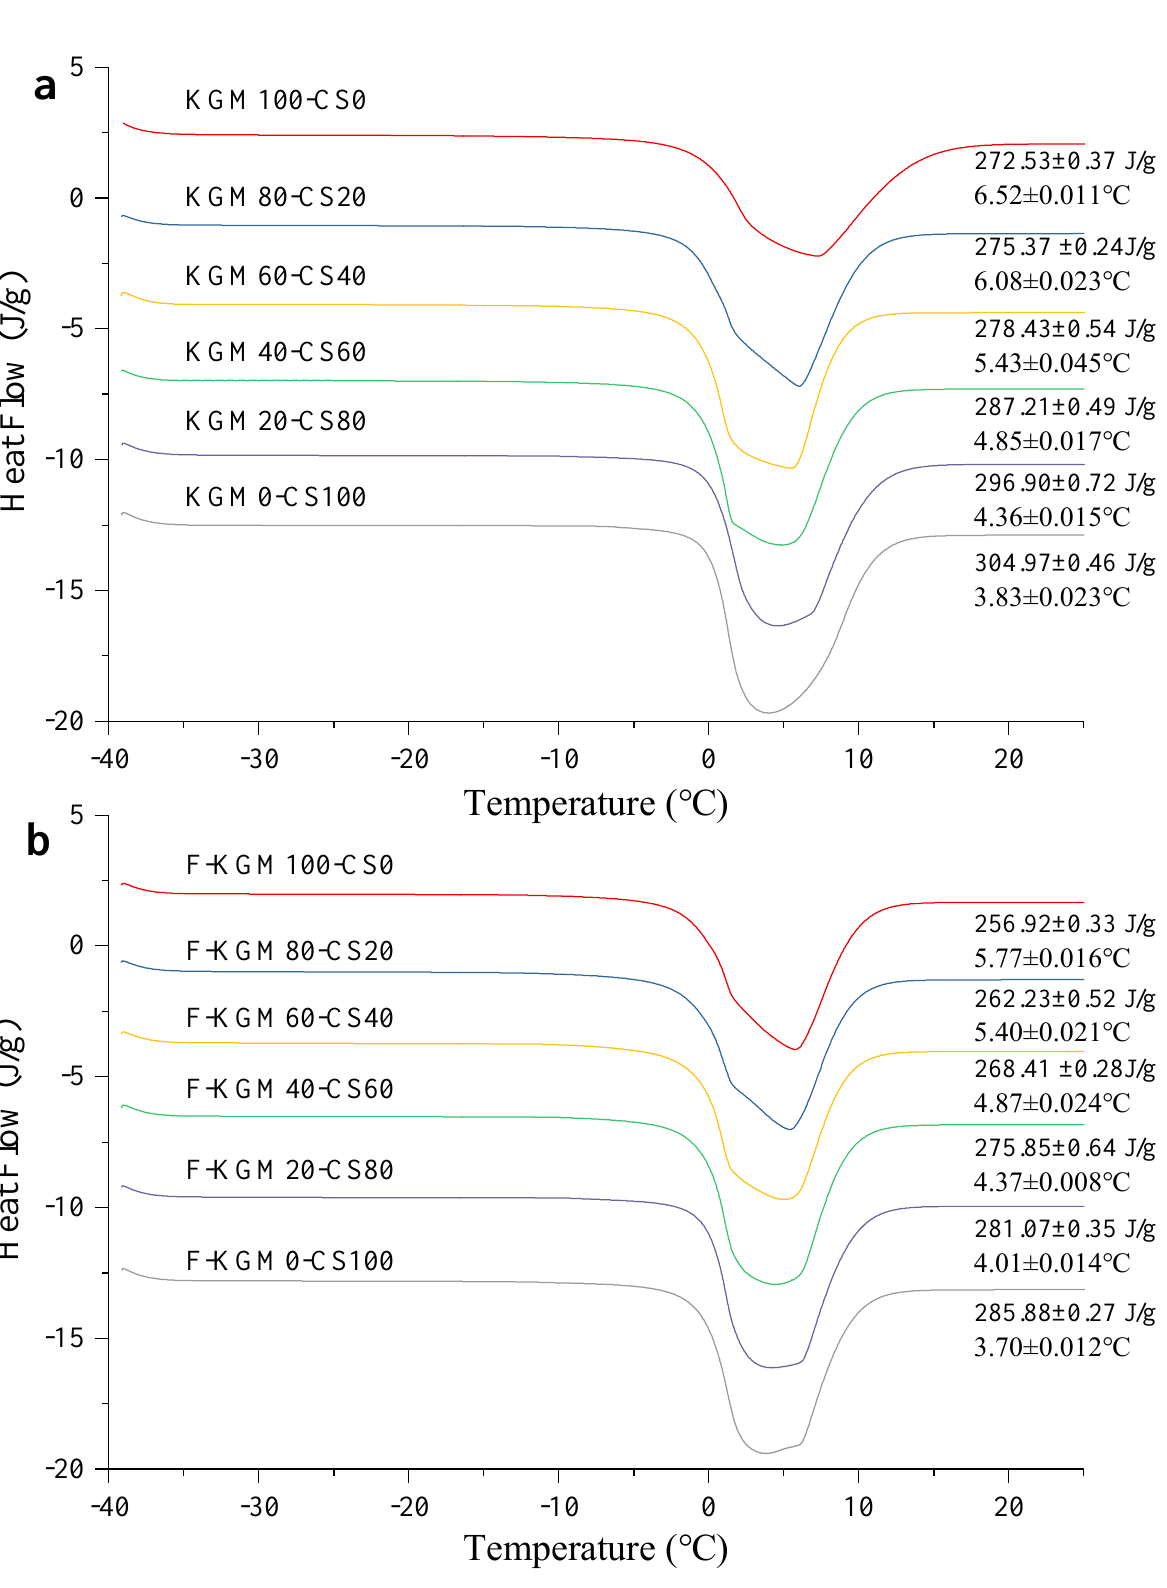
Figure 6. The melting of free water in the composite gels with different KGM/starch ratios: ( a ) KGM–CS gels; ( b ) F–KGM–CS gels.